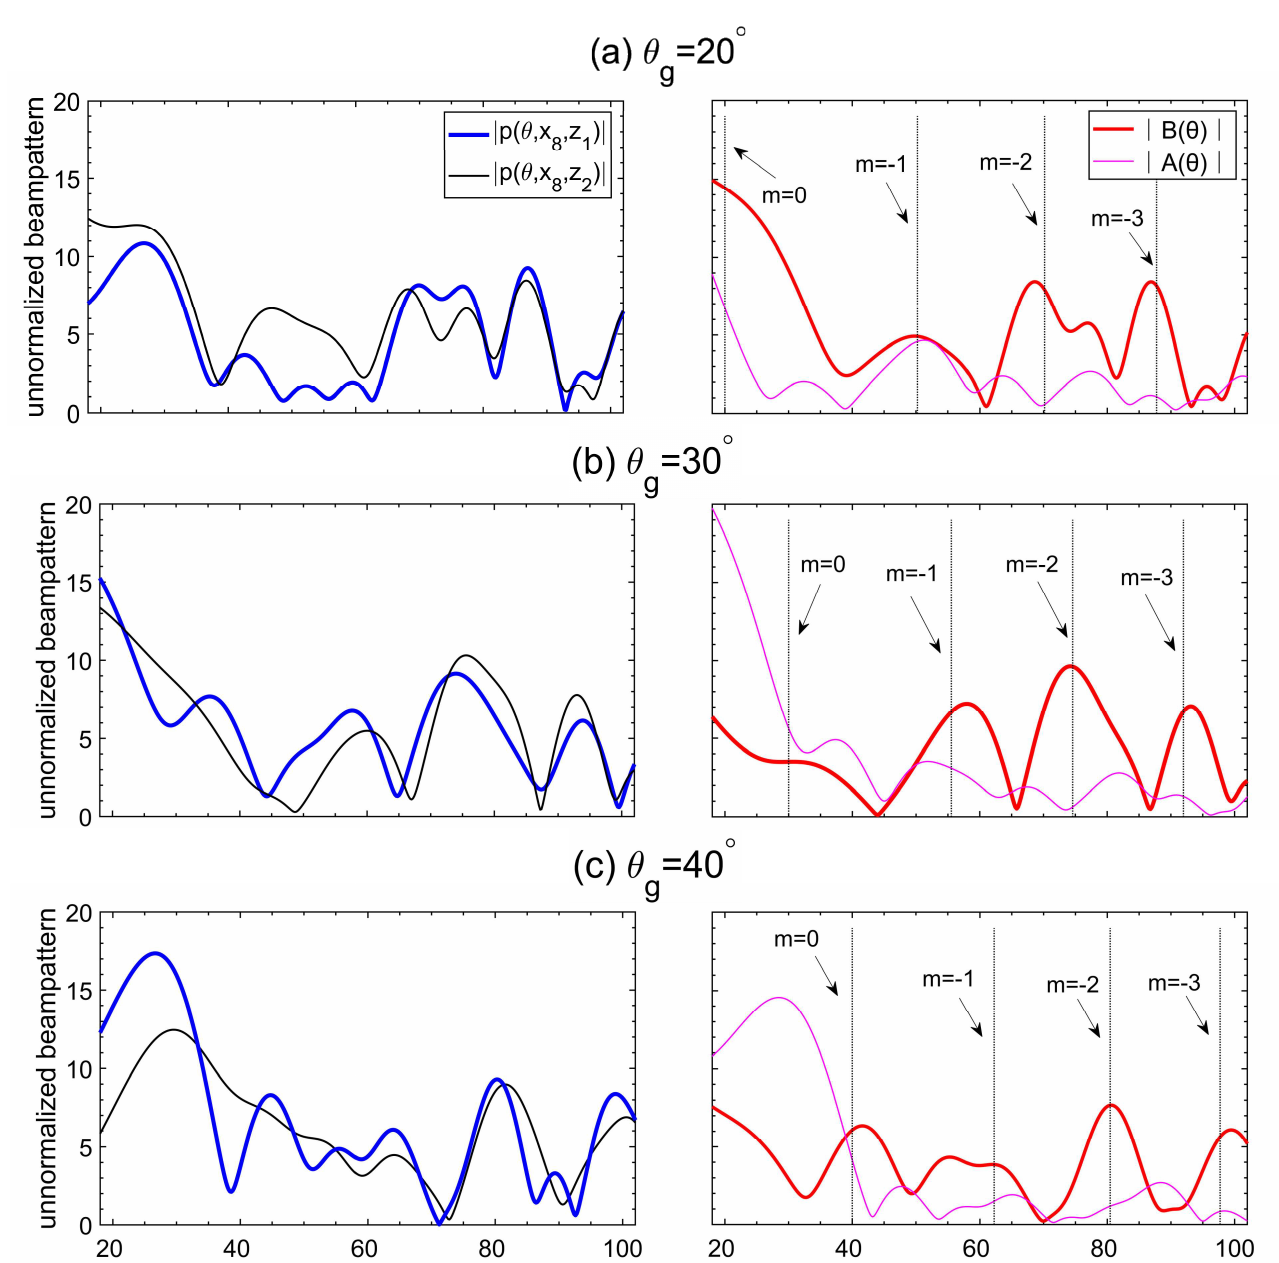
Figure 3. Beamforming output at frequency f = 24.57 kHz ( d = λ /2) for three different incident grazing angles, θ g = 20 ◦ in ( a ), θ g = 30 ◦ in ( b ), and θ g = 40 ◦ in ( c ), where the left column of figure is for the beampatterns obtained just by a single array, and the right column is for the beampatterns of upward ( | B ( θ ) | ) and downward ( | A ( θ ) | ) propagating waves extracted from the beamforming outputs of two single arrays. The dotted lines represent the scattered grazing angles predicted by the Bragg